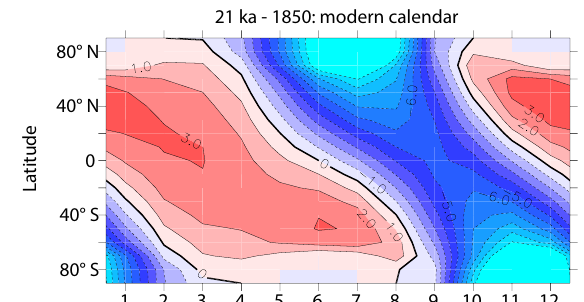
Figure 2. Top of the atmosphere difference in insolation (in Wm − 2 ) for lgm as compared to piControl ( lgm – piControl), as a function of latitude and month of the year. There is no difference related to the calendar, which is the same for piControl and lgm , be- cause the difference between the definition of the modern calendar and the definition based on astronomy is not statistically significant for the LGM orbital